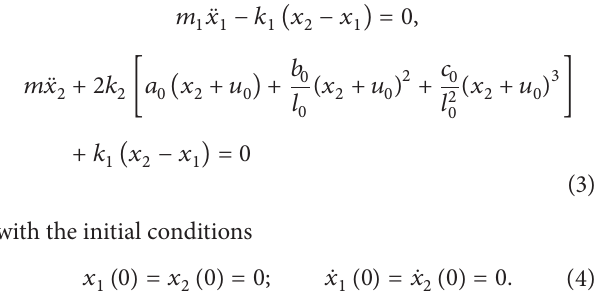
Figure 1: The model of tilted support spring system with critical